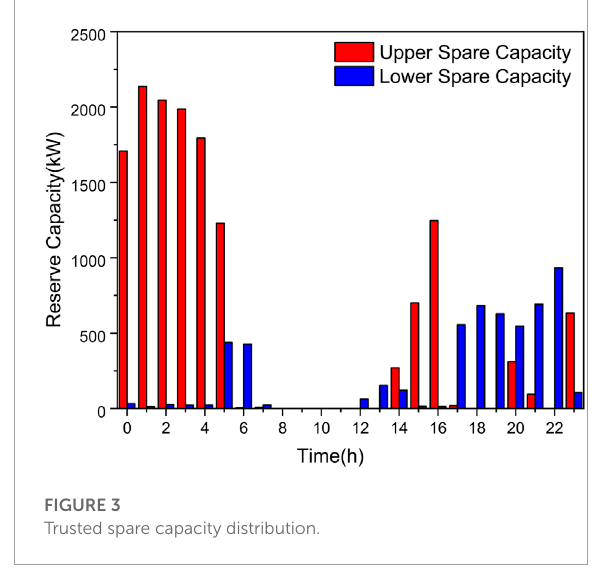
TABLE 1 Parameters of the